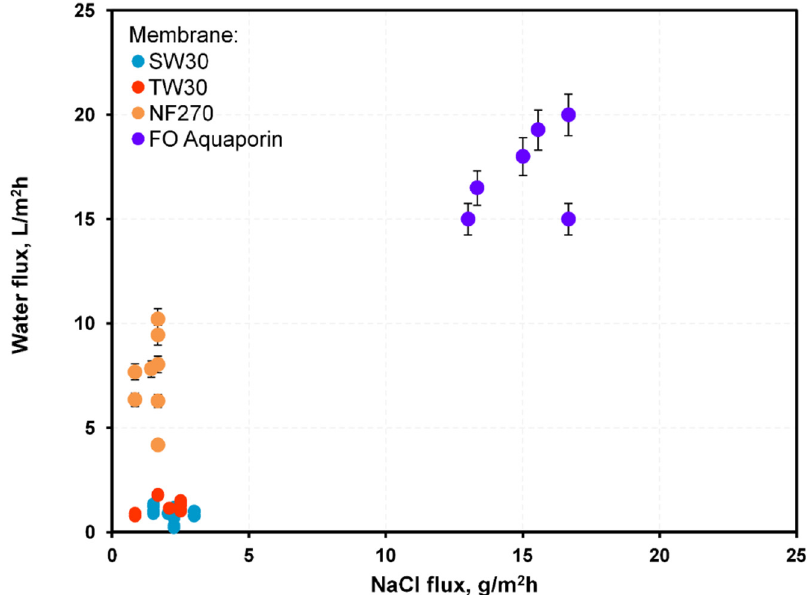
Figure 11. Ratio of measured water to salt fluxes in a water–40%glycerol–3% NaCl system through the membranes in this study.